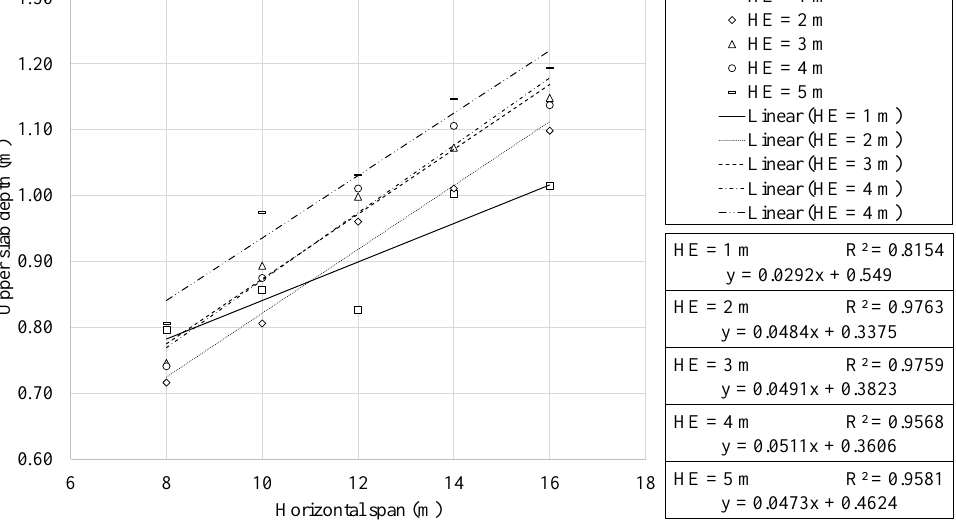
Figure 7. Upper slab depth as a function of the horizontal span.